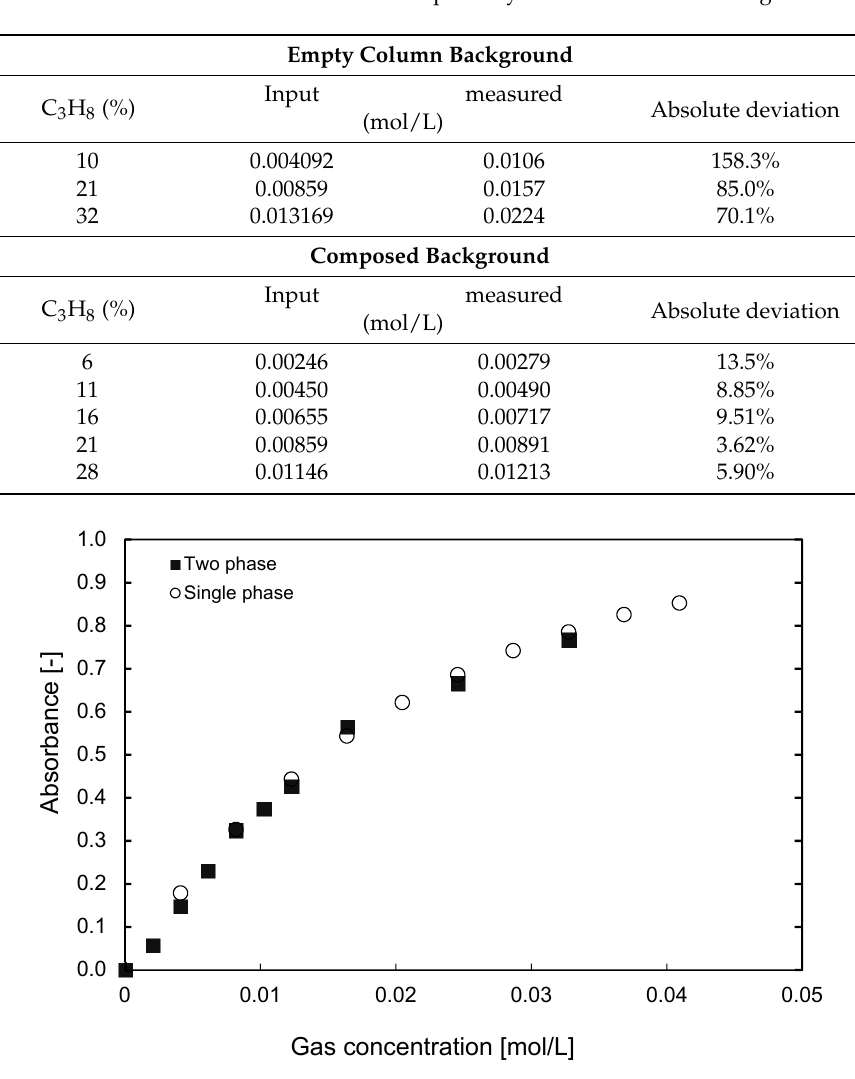
Figure 8. Comparison between the calibration curve of tracer gas concentrations obtained in the empty column and the two phase system using a composed background image.